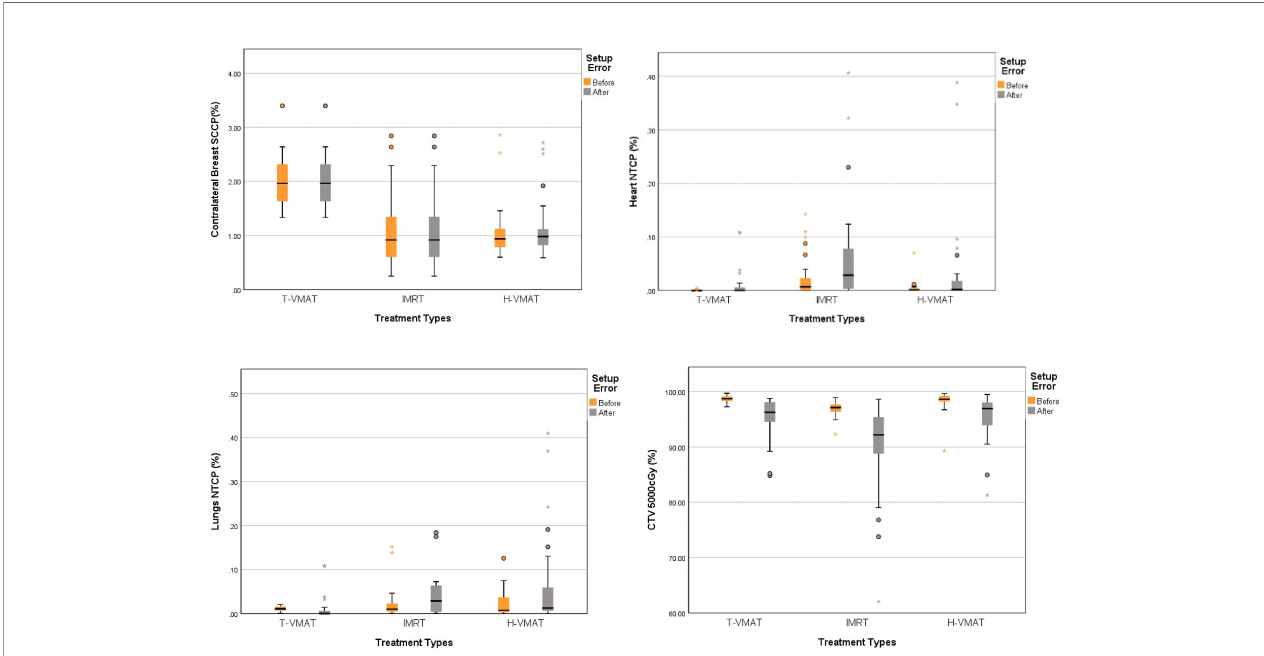
FIGURE 6 | Box-whisker plot of mean radiobiological parameters with error bar: CTV coverage, Contralateral breast SCCP, Heart NTCP, Lungs NTCP with error bars. Each fi gures show the parameters changes of each organs before and after the recalculation of setup error. Gray bars represent the accumulated dose after the consideration of setup error, and yellow bars represent the dose not considered of setup error. The points in the graph represent outliers, the black horizontal lines in the fi gures represent the average of each parameter.